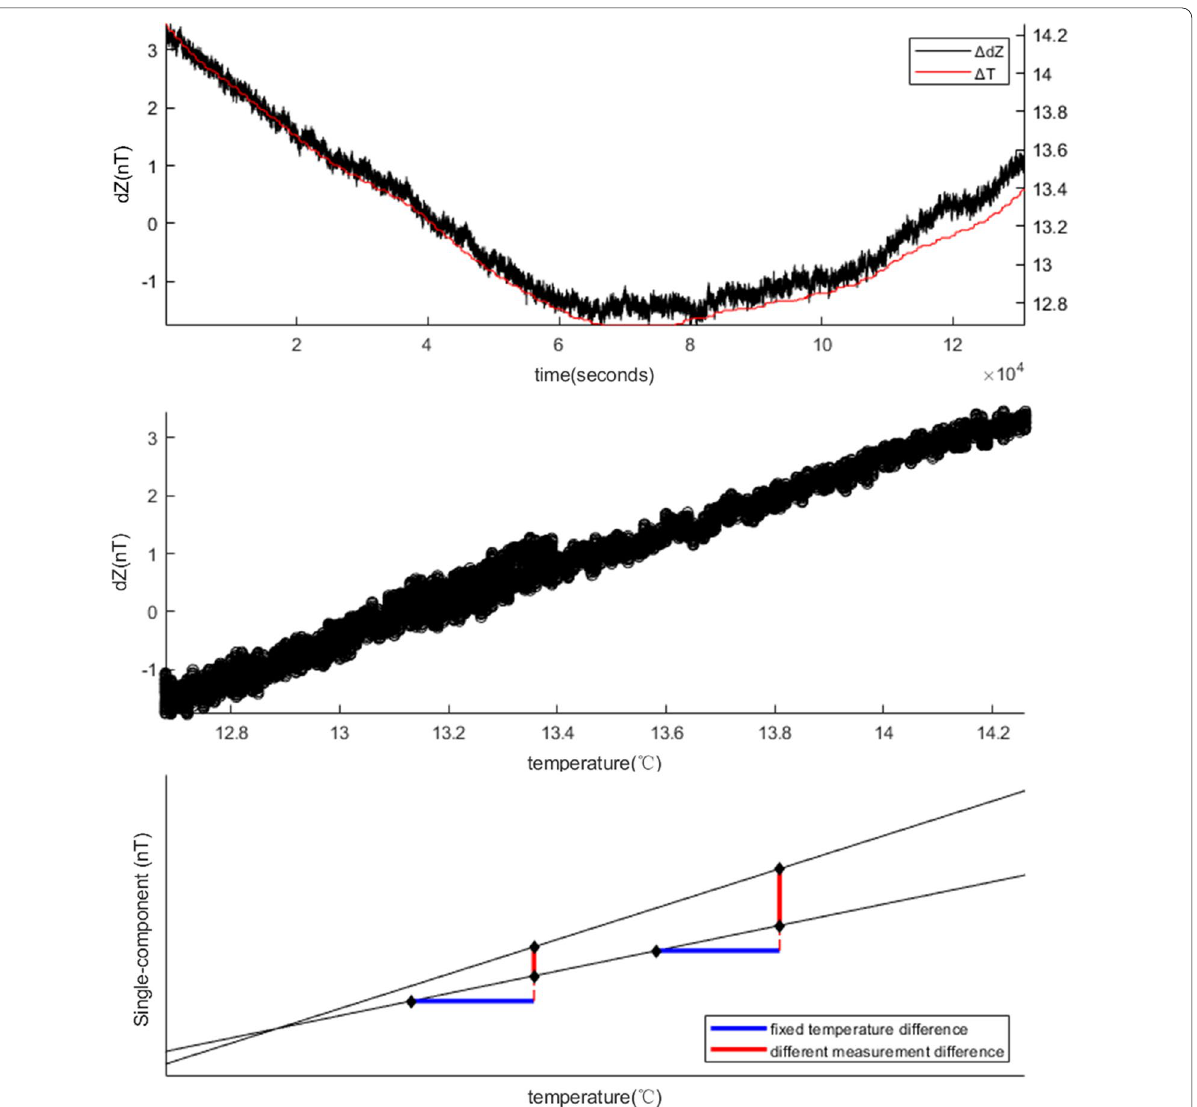
Fig. 2 Influence of temperature on comparative geomagnetic vector observations. The relative temperature coefficient describes the linear effect of the temperature on the vector difference between the comparative observations, mainly resulting from the different temperature coefficients of the two sets of